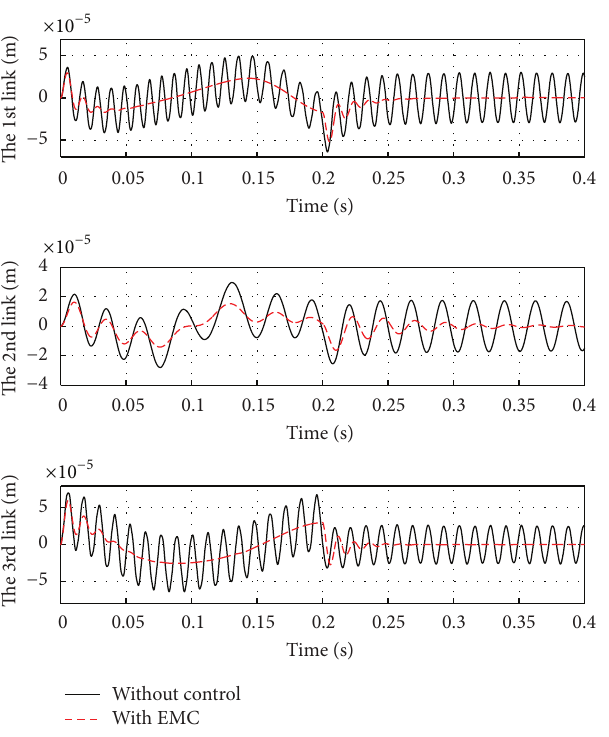
Figure 5: The vibration responses at the three quarters of the three flexible links.